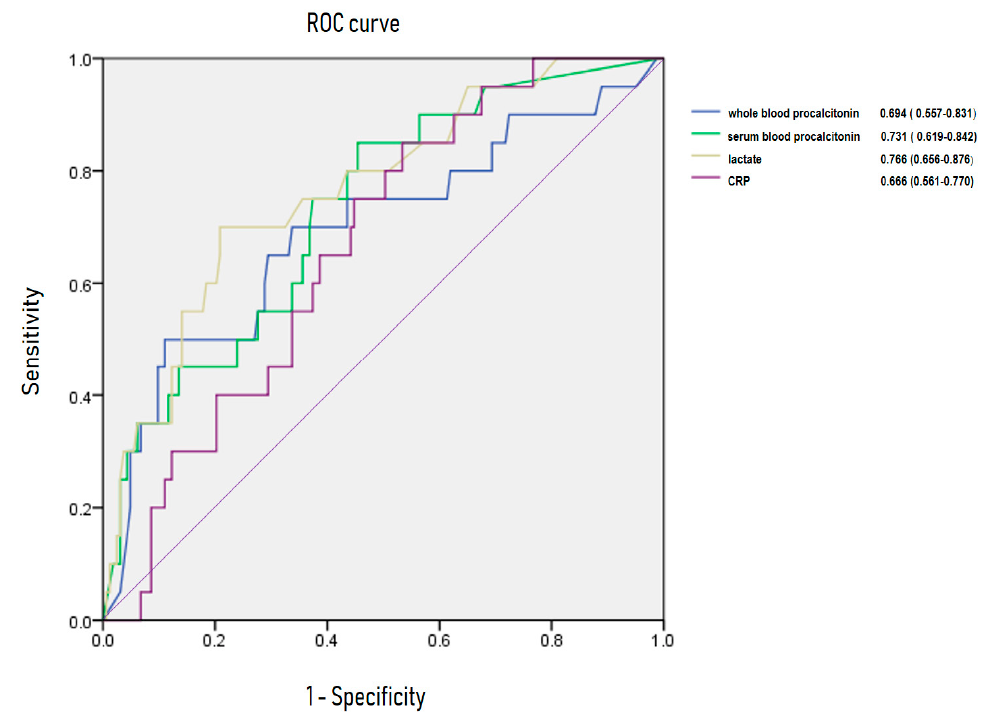
Figure 4. Area under receiving operating curve (AUROC) of C-reactive protein, lactate, procalcitonin for predicting 28-day mortality. 158